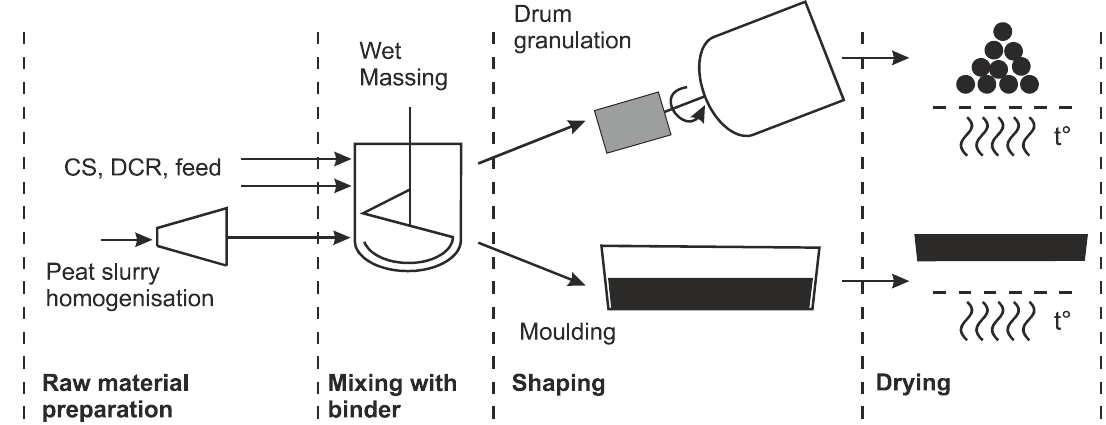
Figure 6. Principal scheme for producing the bio-based binder composite material in the shape of granules and blocks.